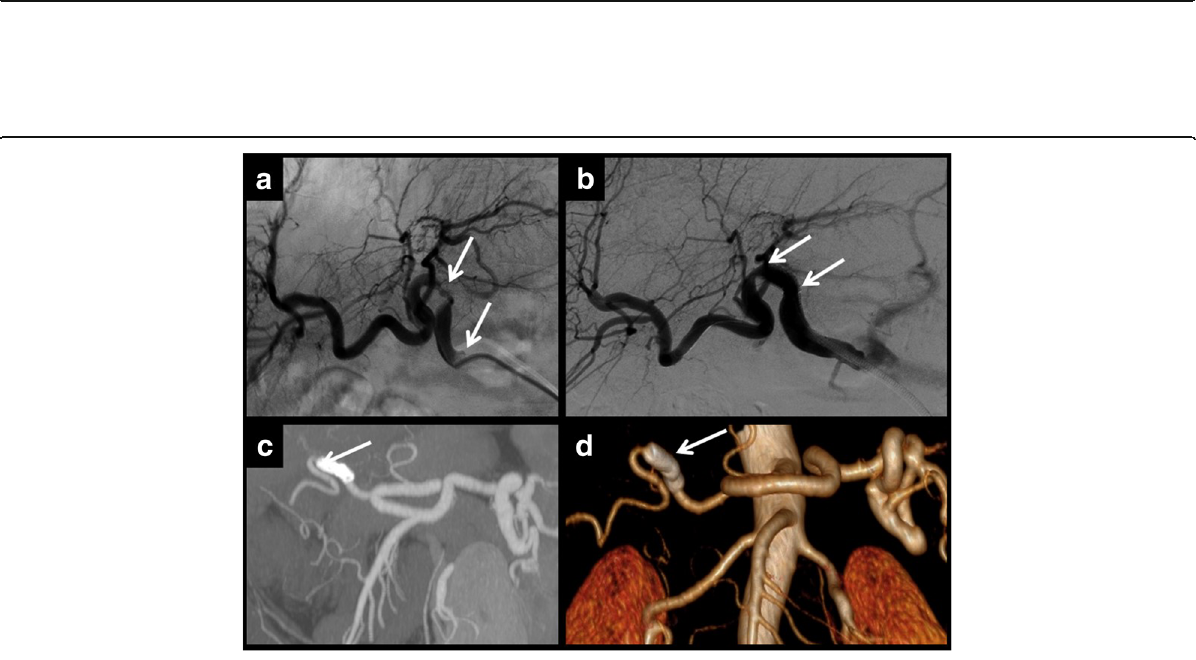
Fig. 5 Multifocal stenosis. The hepatic artery can present more than one point of stenosis. In these cases, each one should be treated separately. In this example, angiography demonstrated two points of stenosis ( a , b ). Two stents were placed for treatment. Control CT showed that stents had been correctly placed and there is distal artery flow as seen in the MIP reconstruction ( c ) and in volume rendering reconstruction ( d